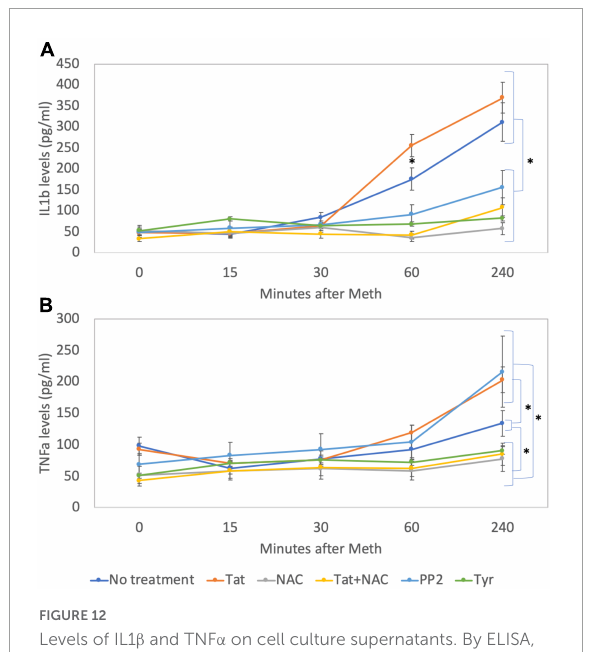
FIGURE12 Levels of IL1 β and TNF α on cell culture supernatants. By ELISA, levels of (A) IL1 β and (B) TNF α were measured in cell culture supernatants at baseline and 15, 30, 60, and 240 min after addition of Meth (60 uM) to the cultures. The lines indicate cytokine levels upon the co-incubation with Tat (10 ng/ml), NAC (1 uM), Tyr (1 uM) and PP2 (1 uM). Results are the mean ± SD of triplicates, in 2 independent experiments. * p < 0.05 in repetitive measures ANOVA.